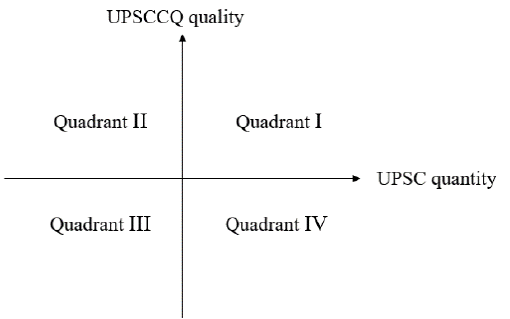
Figure 2. The analysis framework of UPSCC from qualitative–quantitative